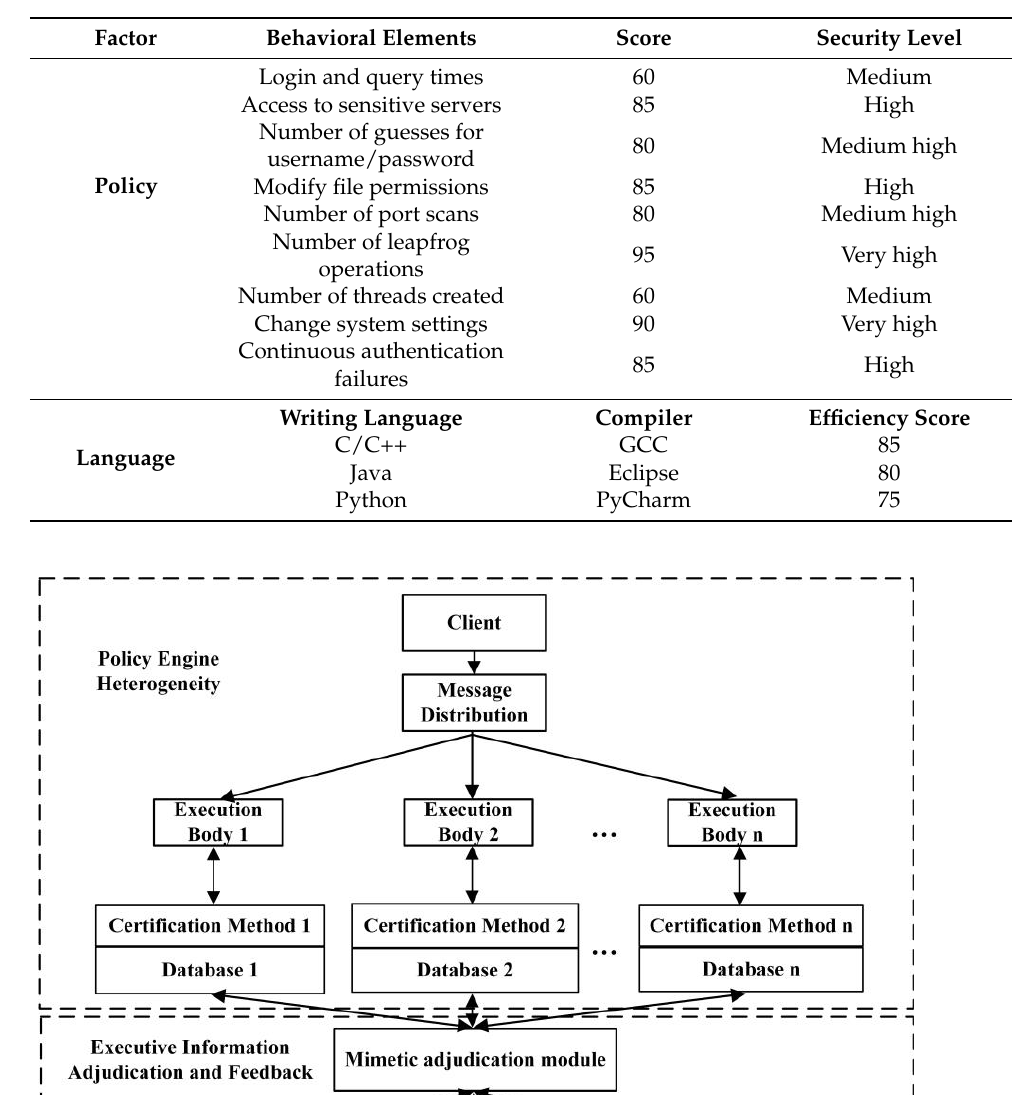
Table 1. Diversity policy engine.